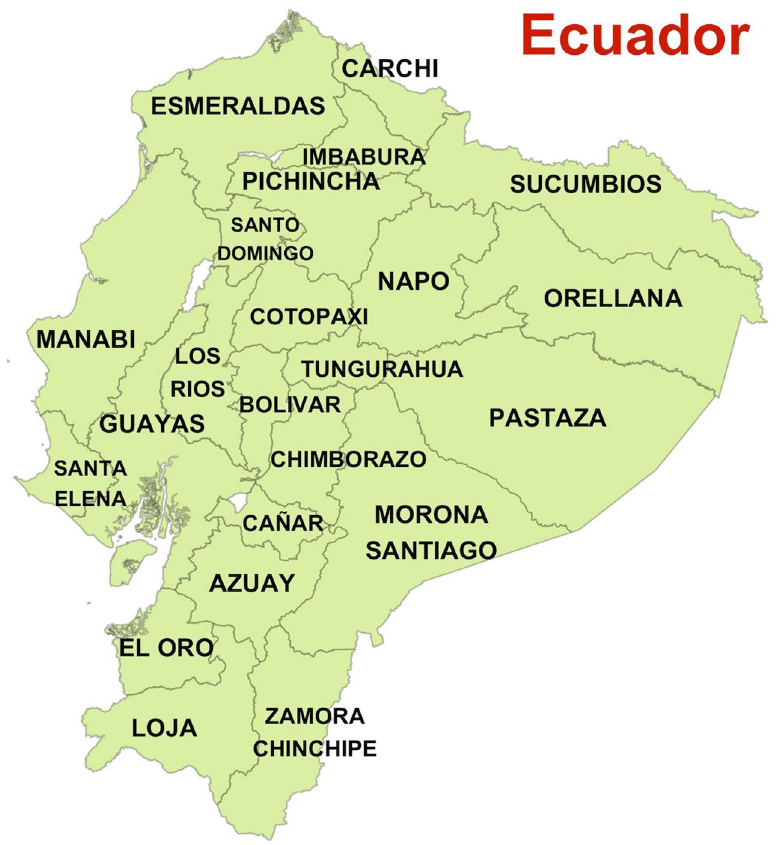
Figure 1. Map of Ecuador with provinces Figure created in R version 4.0.3 (https:// www.r- proje ct.